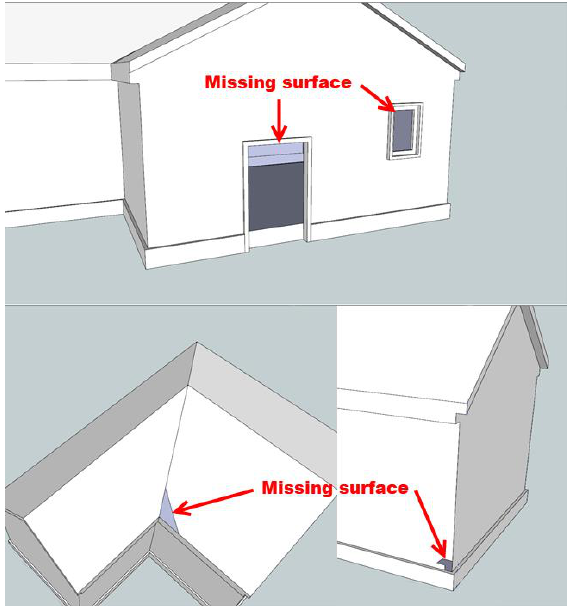
Figure 6 . Missing surfaces available in the